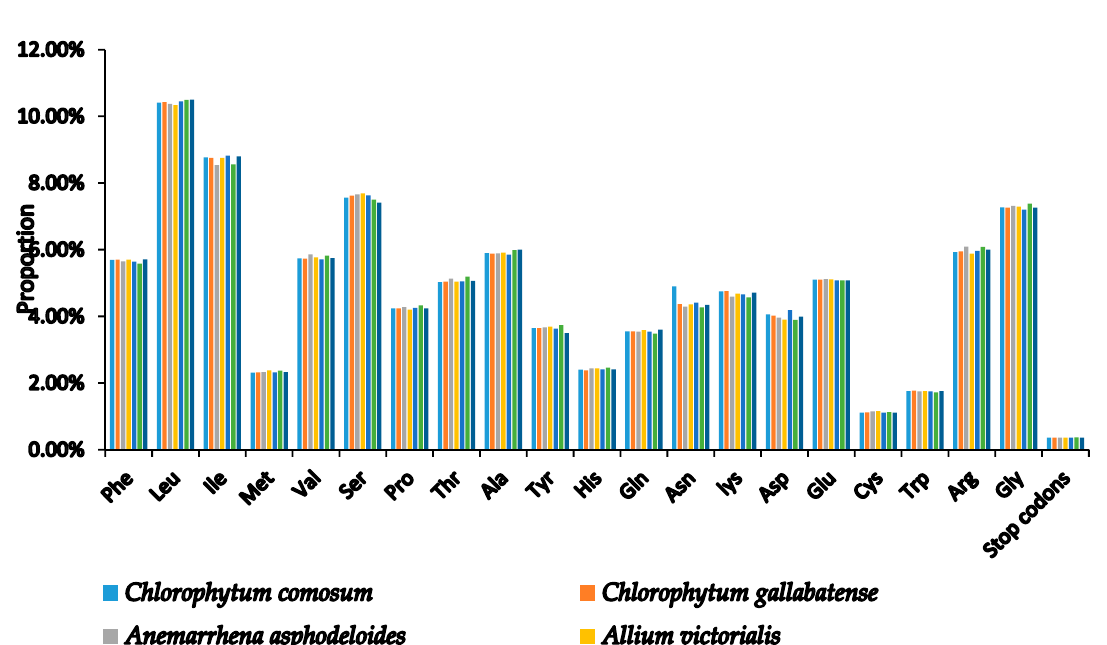
Figure 2. Amino acid proportion in C. comosum and C. gallabatense protein-coding sequences.